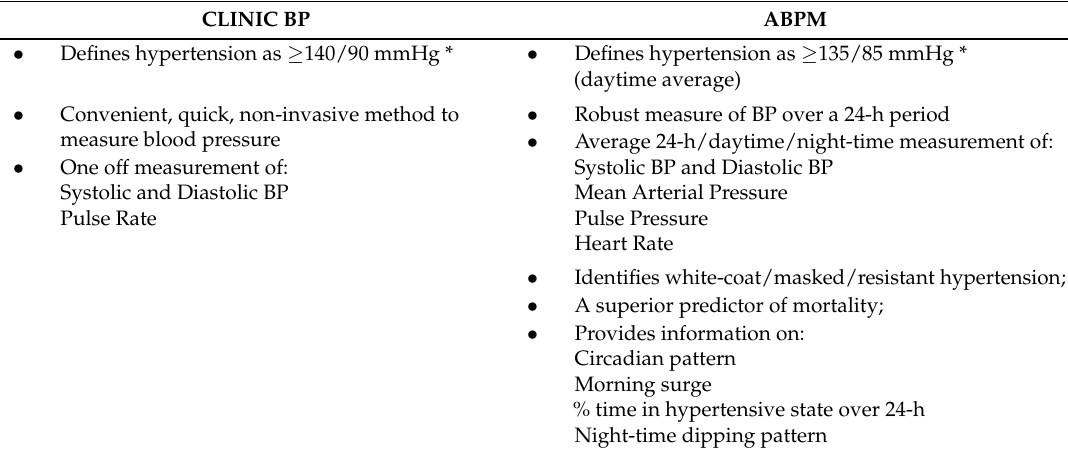
Table 1. Clinic BP vs.